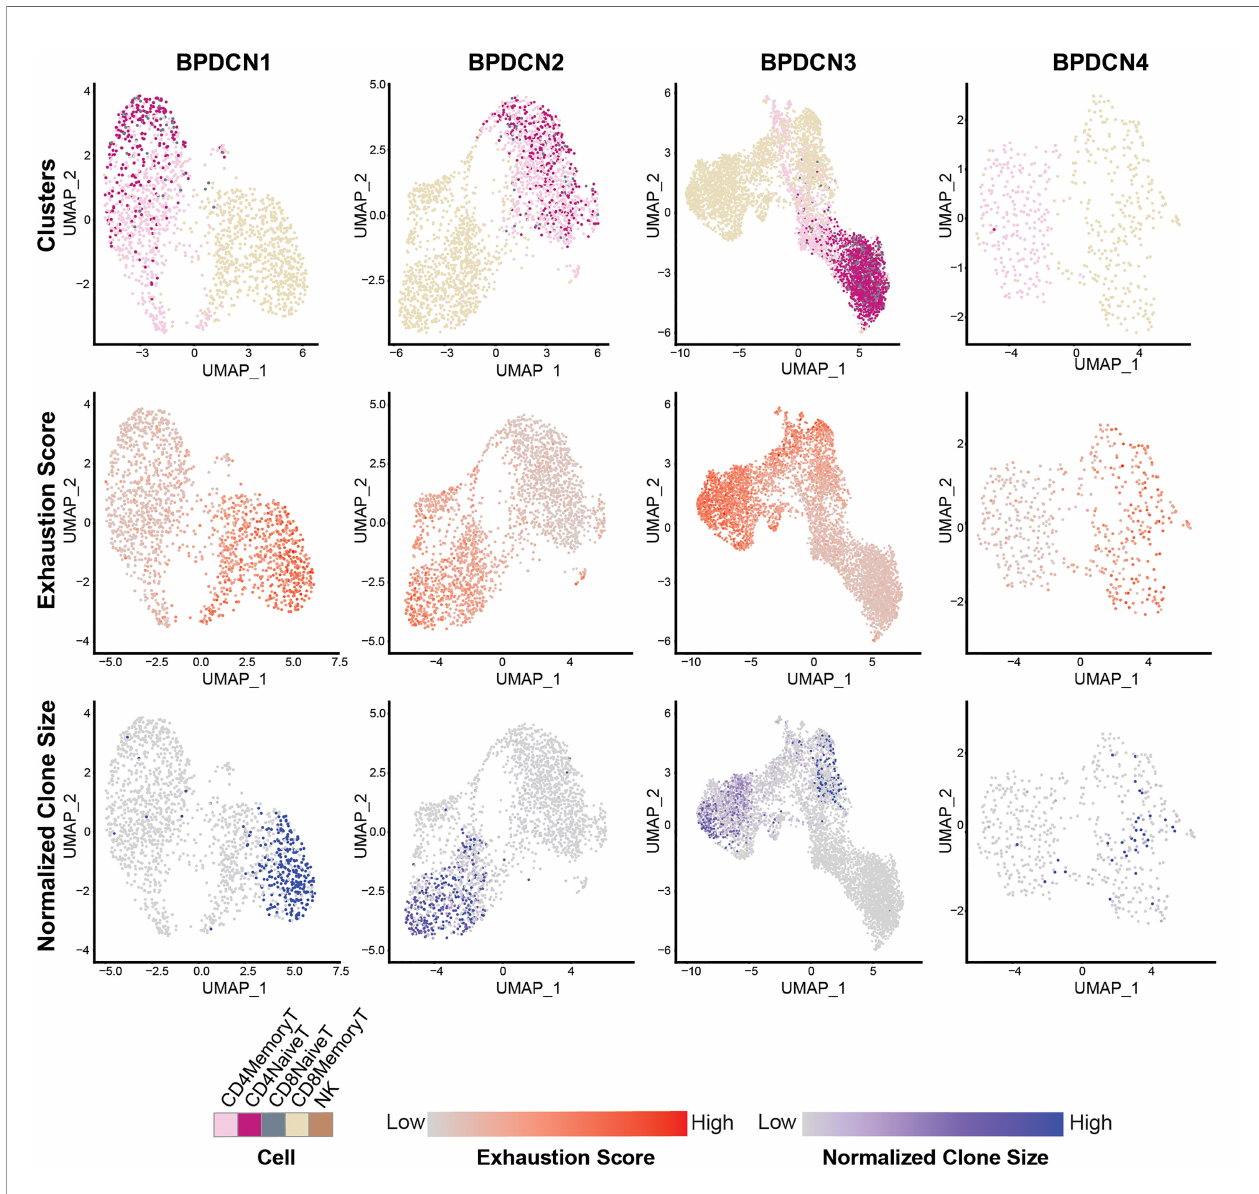
FIGURE 7 | CD8+ Memory T-cells exhibit high expression of T-cell exhaustion-associated genes and larger TCR clones. UMAP plots of T-cell populations in each BPDCN sample that contains T-cells (BPDCN 1-4), separated by column. UMAPs are colored by cluster ( fi rst row); T-cell exhaustion score, with red indicating high exhaustion and gray indicating low exhaustion (second row); and normalized clone size, percentage of all cells in the dataset that share the same TCR sequence, with blue indicating high clone size and gray indicating low clone size (third